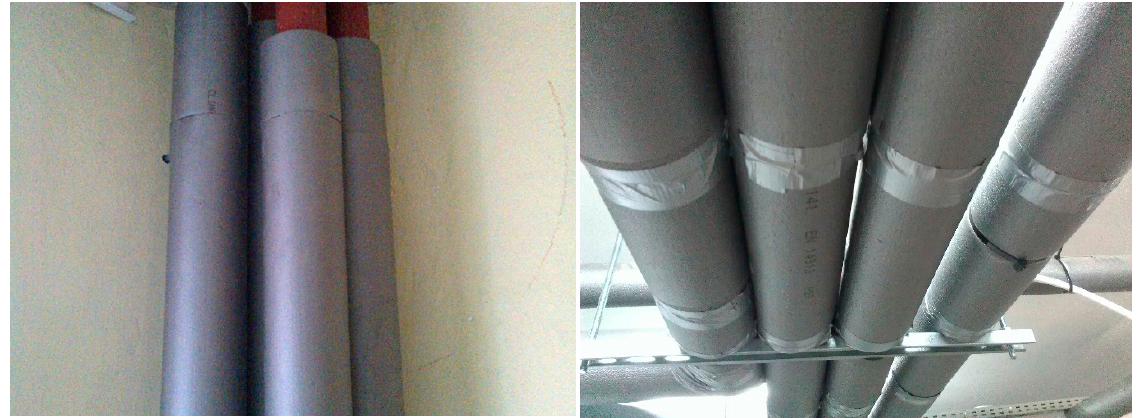
Figure 4. Thermal insulation on pipes under consideration (photo taken by the author).